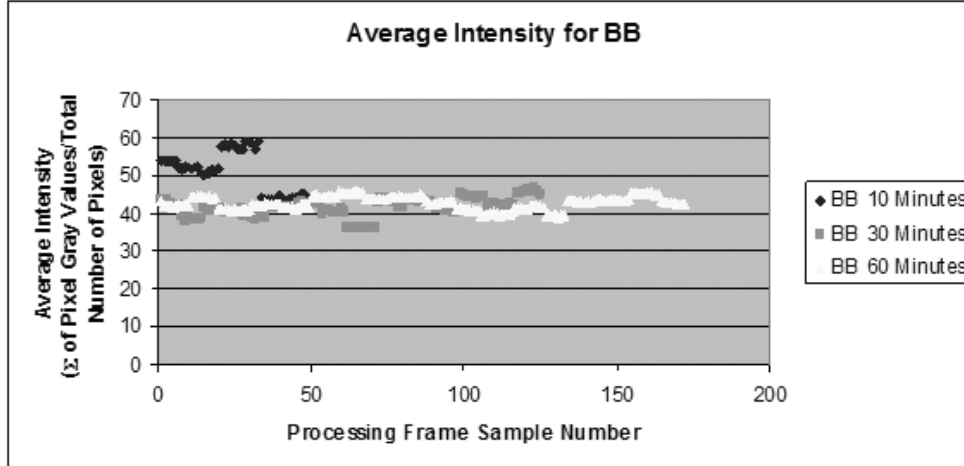
Figure 15: Average Intensity of wear for BB after each stage of the experiment.